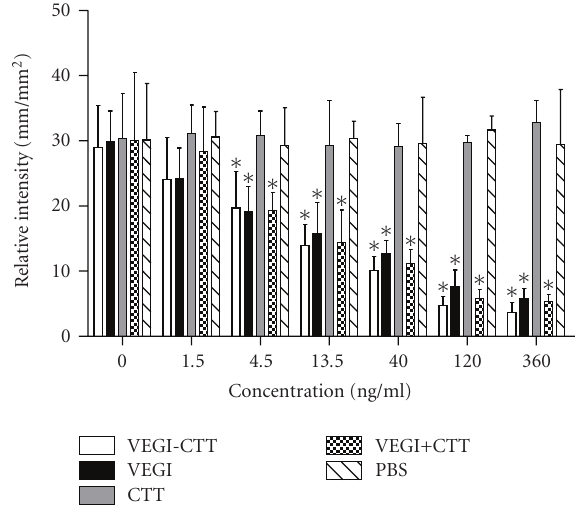
Figure 6: Inhibition of formation of capillary-like tubules by adult bovine aortic endothelial (ABAE) cells in collagen gels. The experiments were carried out in triplicate. At least 9 image areas were analyzed for each VEGI concentration. Mean values and standard deviations are presented as a function of VEGI concentration. ∗ P < . 05 versus that of PBS